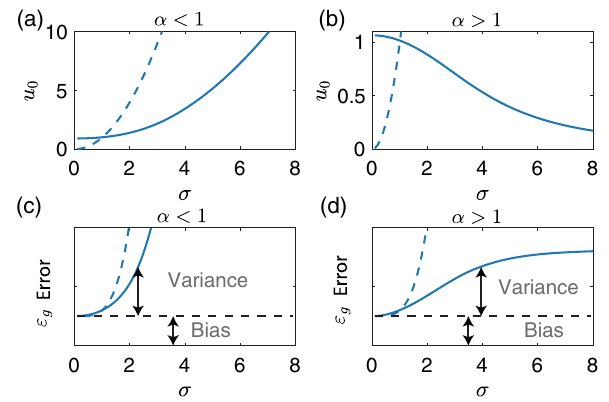
FIG. 2. (a,b) Dependence of the order parameter u 0 on the noise parameter σ in wide [(a); α ¼ 0 . 8 ] and narrow networks [(b); α ¼ 1 . 1 ]. Blue solid lines: theory. Blue dashed lines: the prediction of GP theory ( u 0 ¼ σ 2 Þ . In both panels (a) and (b), u 0 is finite for low σ . Additionally, in panel (a), ( α < 1 ) u 0 diverges as σ 2 ð 1 − α Þ for σ → ∞ , slower than in the GP theory. In panel (b), for α > 1 , u 0 vanishes as σ → ∞ , which is drastically different from the GP. (c,d) Dependence of the generalization error on σ for wide ( α ¼ 0 . 8 ) and wide ( α ¼ 1 . 1 ) regimes. The change with σ is due to the change in variance, which scales as σ 2 u 0 [Eq. (26)]. The bias contribution is independent of σ , Eq. (25) and black dashed lines. (c) Generalization error diverging slower than in GP theory for α < 1 as σ → ∞ . (d) Generalization error increasing and approaching a finite limit as σ → ∞ for α > 1 , in stark contrast to the divergence predicted by the GP